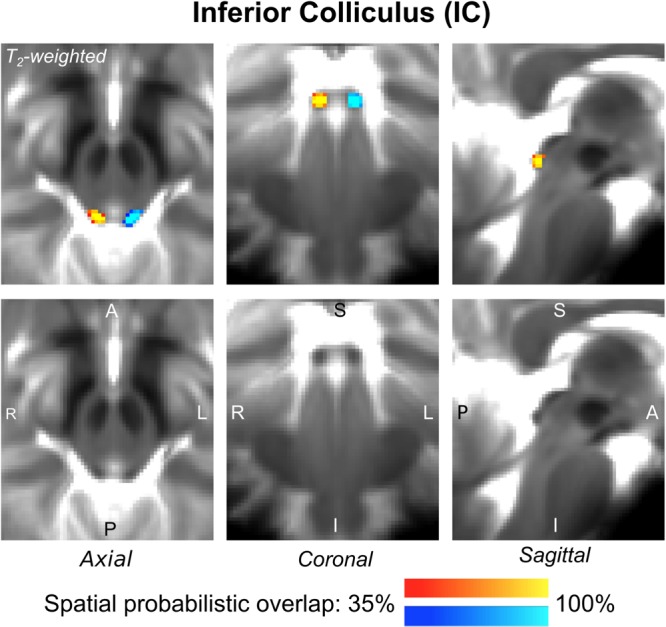
Probabilistic atlas label in MNI space of the IC (left: blue-to-cyan; right: red-to-yellow). The IC was hypointense in T2-weighted MRI; its label is overlaid on the group average T2-weighted image. Very good (i.e., up to 100%) spatial agreement of labels across subjects was observed indicating the feasibility of delineating the probabilistic label of this nucleus involved in auditory and auditory-motor functions.